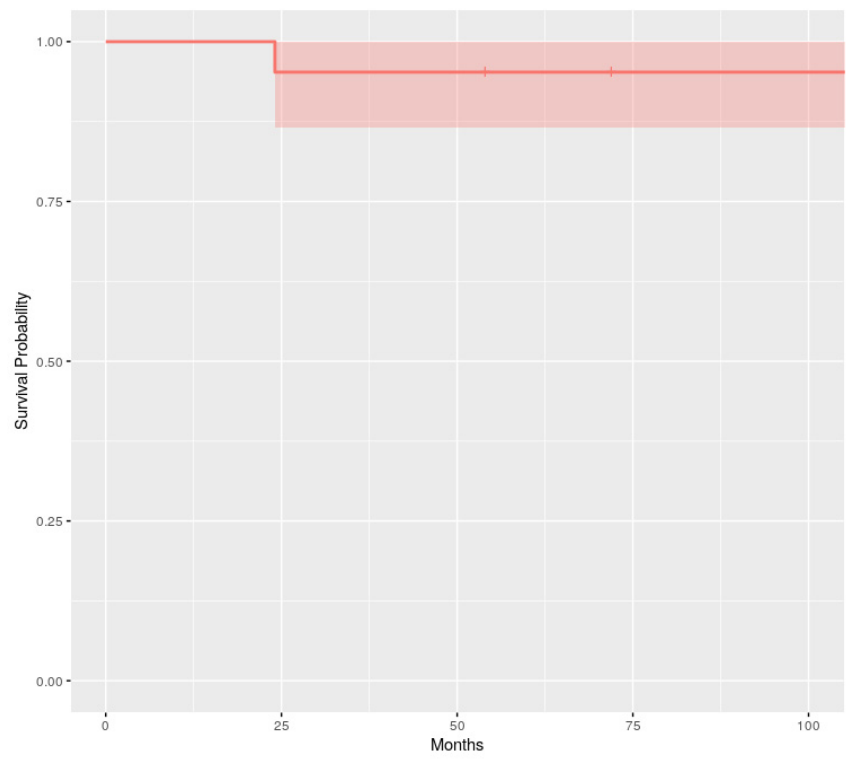
Figure 9. Kaplan–Meier survival curve for the FRCB (overall survival estimation and confidence interval).